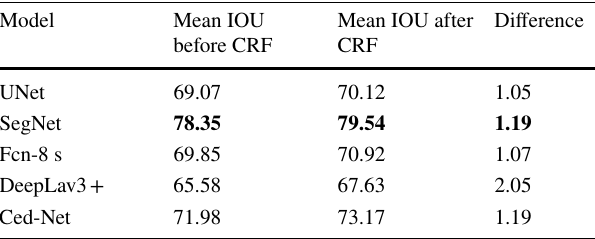
Table 4 A comparison of enhancement results of four semantic seg- mentation